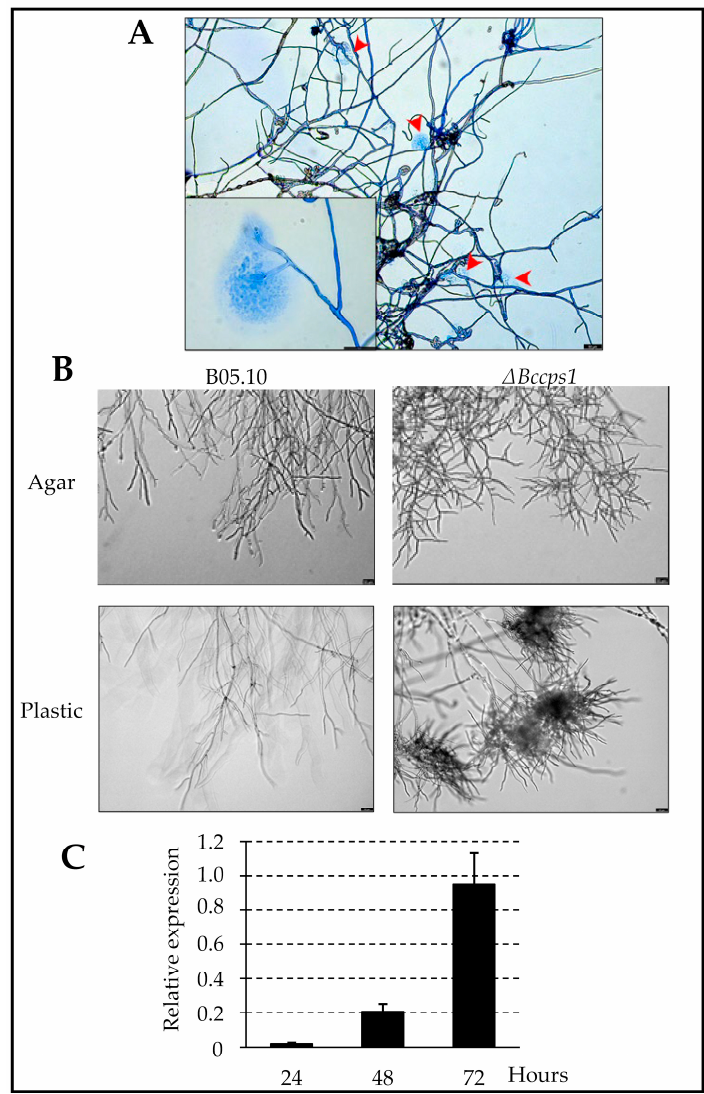
Figure 3. BcCps1 is involved in hyphal development 24 h after conidia germination. ( A ) Rupture and cell content leakage events (red arrows) in the hyphae of the mutant strain growing out of medium droplets on a plastic surface. Hyphae were stained with cotton blue. Scale bar: 50 nm—inlet: higher magnification. ( B ) Parental (B05.10) and mutant ( Δ Bccps1 ) hyphal development following conidia germination (after 24 h) on a rich solid medium (Agar) and inside a droplet of rich medium on a plastic surface (Plastic). Scale bar: 50 nm. ( C ) Expression kinetic of the Bccps1 gene (relative to the expression of three reference genes ( BcactA , Bcef1 α and Bcpda1 ) in the parental strain grown for 72 h in a rich liquid medium. Means and standard deviations were calculated based on three inde- pendent experiments ( n = 9).